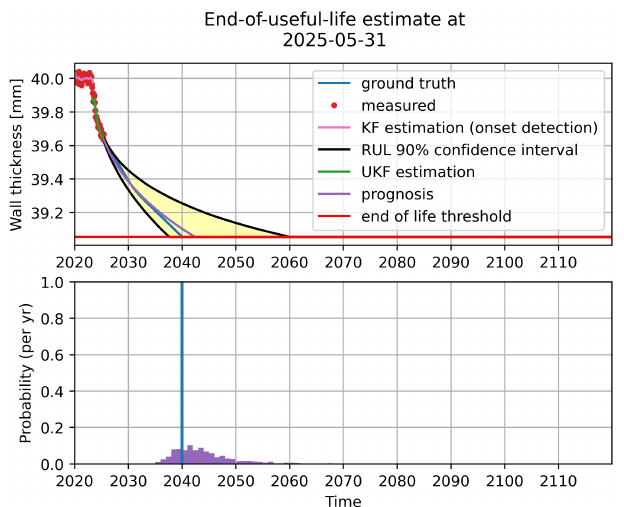
Figure 3. Output of the corrosion prognosis algorithm based on the power-law corrosion model on (simulated) measurement data, along with the ground truth for reference, see also